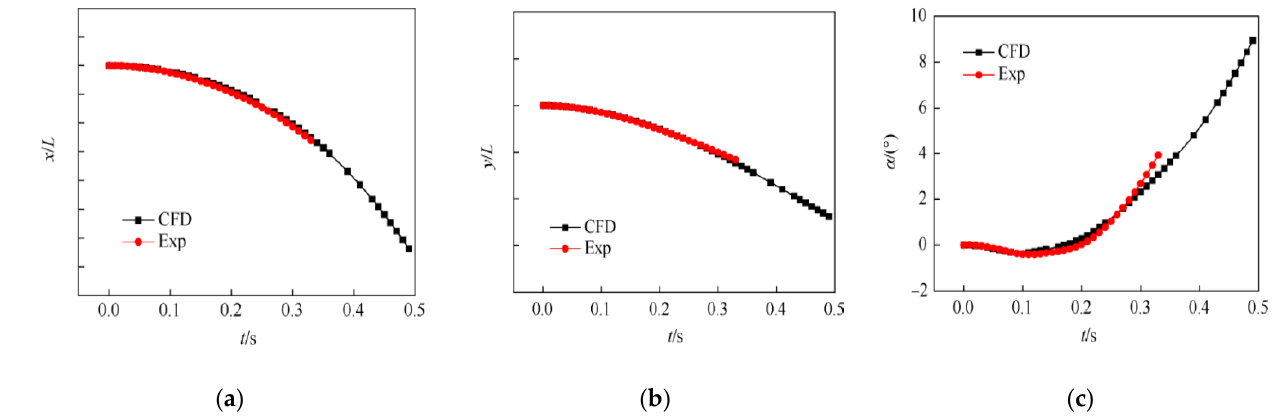
Figure 14. Comparison between numerical simulation and wind tunnel test: ( a ) x-direction distance; ( b ) y-direction distance; ( c ) pitch angle. [44].